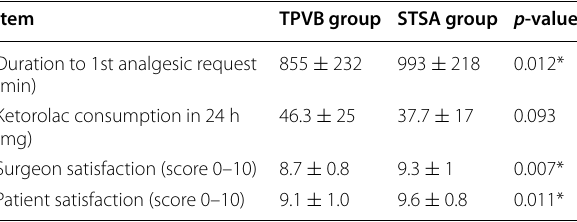
Table 9 Data of postoperative analgesia and satisfaction for patients and